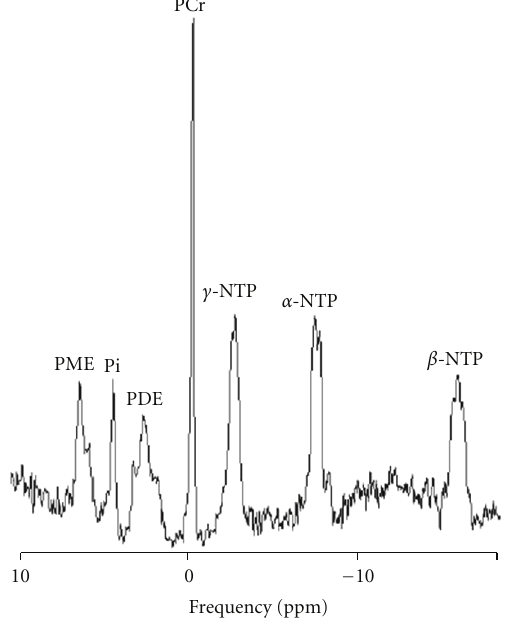
Figure 2: Phosphorus ( 31 P) magnetic resonance spectrum of the whole brain at 3 Tesla (TR = 3000 ms, TE = 2.3 ms). PME = phos- phomonoester; Pi = inorganic phosphate; PDE = phosphodiester; PCr = phosphocreatine; NTP = Nucleoside Triphosphate; ppm = parts per